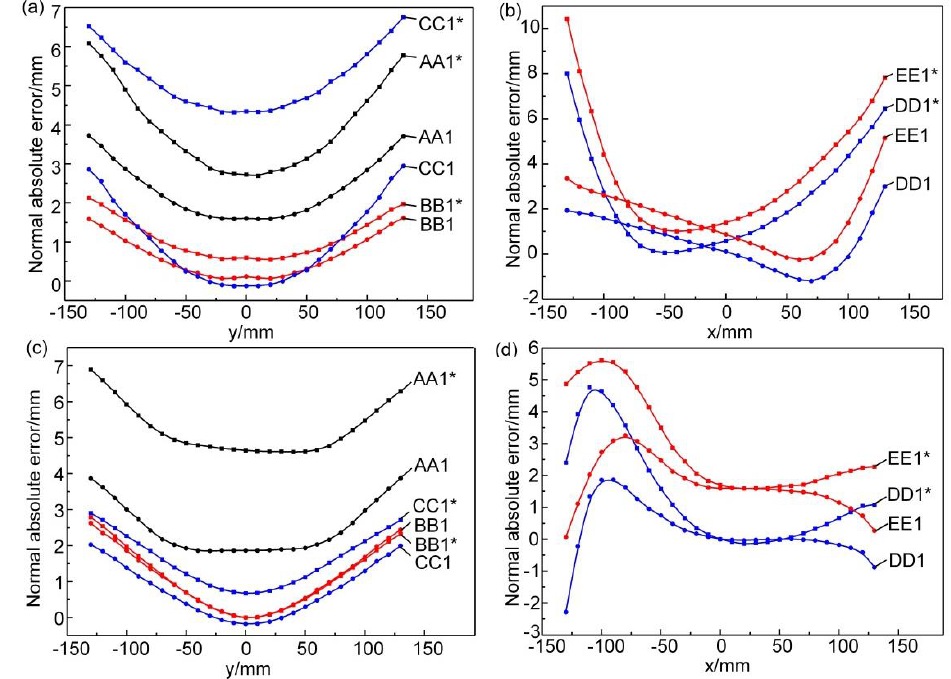
Figure 14. Normal absolute errors for 3D surfaces (A superscript asterisk indicates before correction): ( a ) transversal profiles of convex surface; ( b ) longitudinal profiles of convex surface; ( c ) transversal profiles of saddle surface; ( d ) longitudinal profiles of saddle surface.